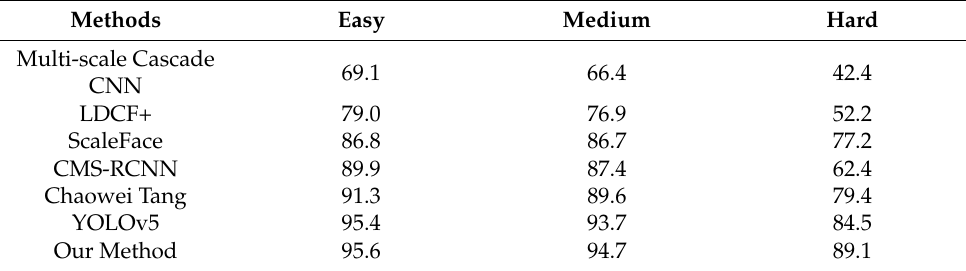
Table 2. Comparison with the typical method based on the rectangle box.